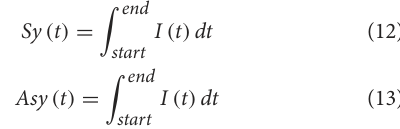
respectively. “Sy” represented the integration under the curve of dynamic transmission power parameters for symptomatic infections, and “Asy” represented the integration under the curve of dynamic transmission power parameters for asymptomatic infections. The area under the curve represented the total transmission power. The results for the total transmission power of asymptomatic and symptomatic infections in the